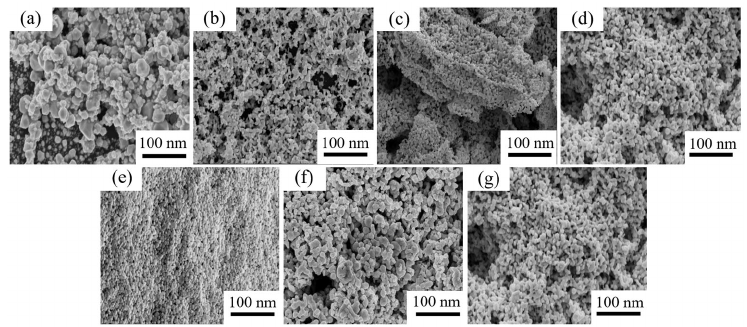
Figure 5. SEM images of sintered products of different MOD: ( a ) MOD1, ( b ) MOD2, ( c ) MOD3, ( d ) MOD4, ( e ) MOD5, ( f ) MOD6, ( g ) MOD7.